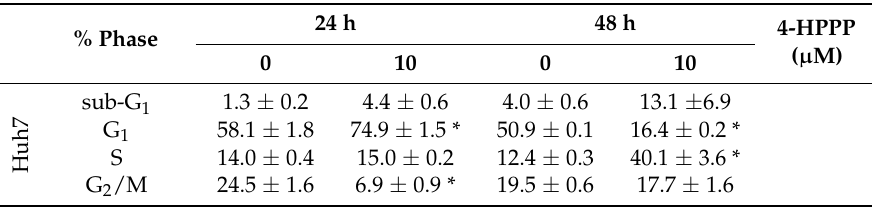
Table 1. The distributions of cell cycle in 4-HPPP-treated Huh7